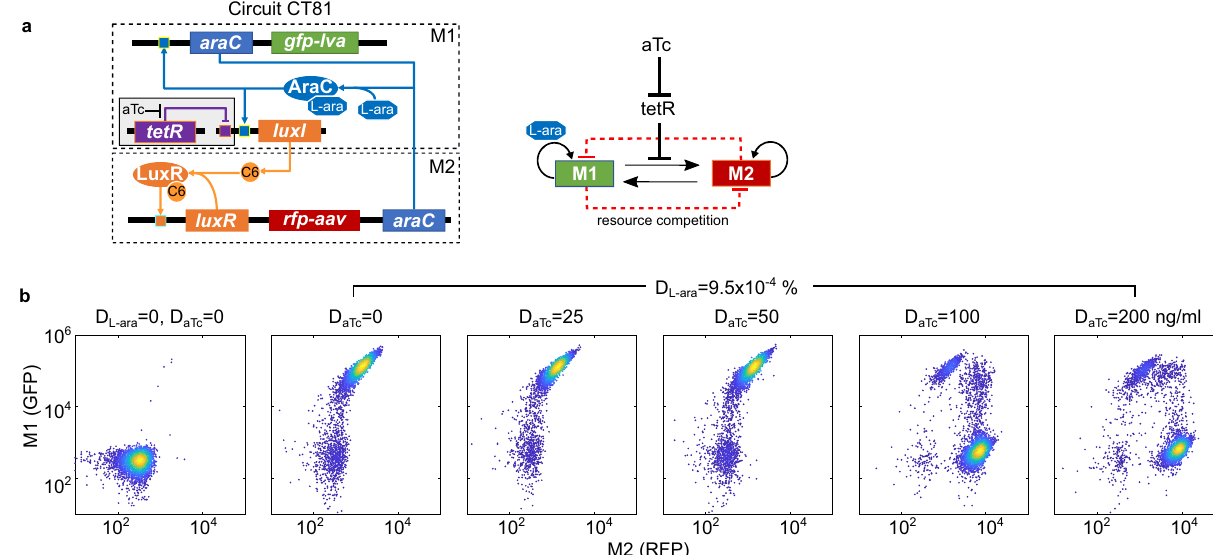
Fig. 4 Relative strength of module connections determines the winner of resource competition. a Diagram of the hybrid Syn-CBS circuit with a tetR module for fi ne-tuning the connection between two bistable switch modules. A hybrid promoter Para/tet is used for controlling the production of C6 to tune the M1-to-M2 connection. b Flow cytometry data showed cell state transitions with various doses of inducer aTc ( D aTc ) and a fi xed dose of L-ara ( D L-ara ). In total, 10,000 events were recorded for each sample. Data from one representative of fi ve independent biological replicates. Circuit CT81 was used here. Source data are provided as a Source Data fi